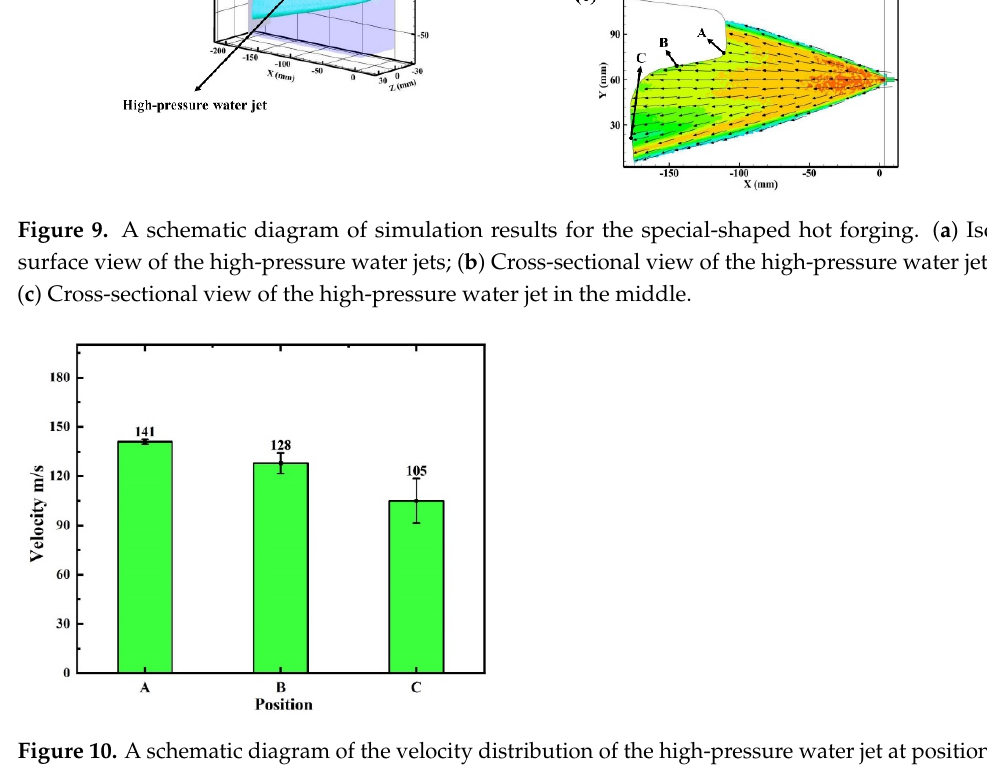
Figure 11. The special ‐ shaped hot forging of 300 M steel after descaling.